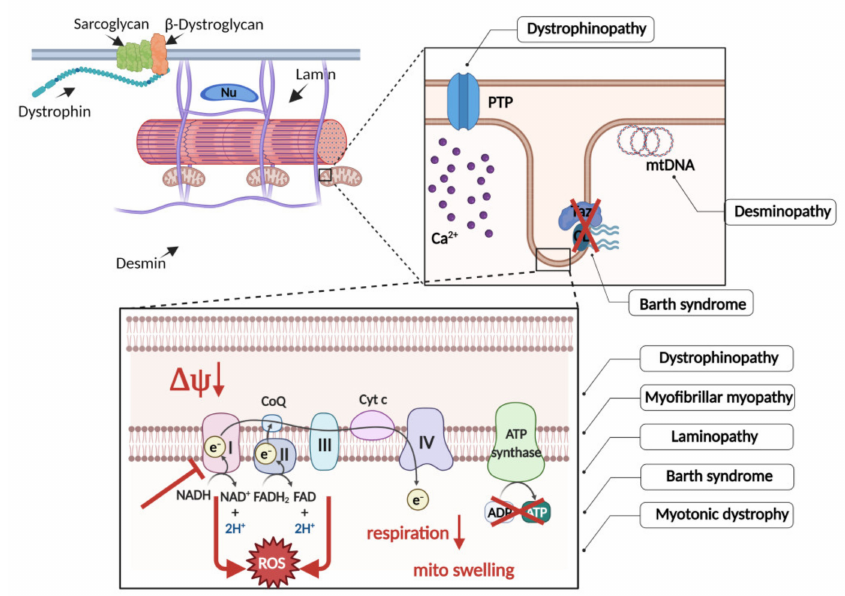
Figure 1. The mutations in different genes that lead to the disruption of the structural and functional integrity of muscle cell trigger the wide spectra of mitochondrial dysfunctions in specific skeletal muscle